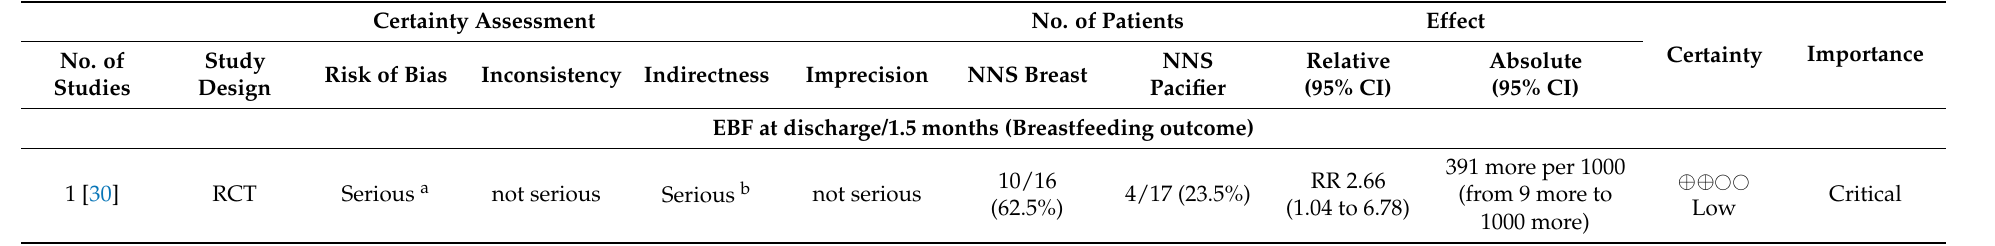
Table 3. GRADE evidence profile: Non-nutritive suckling (NNS) on breast compared to NNS on pacifier for infants u6m with growth faltering. Certainty Assessment